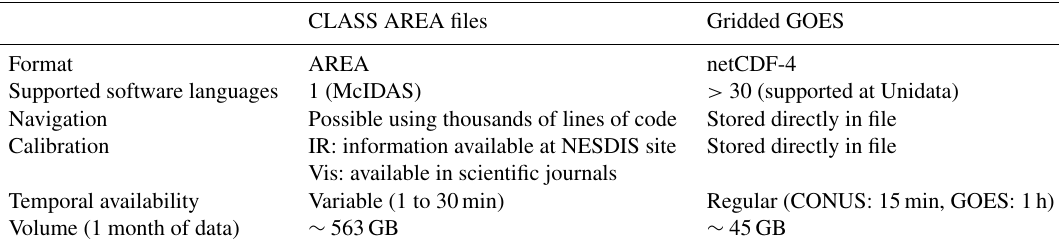
Table 1. Summary of GOES data access for AREA files.